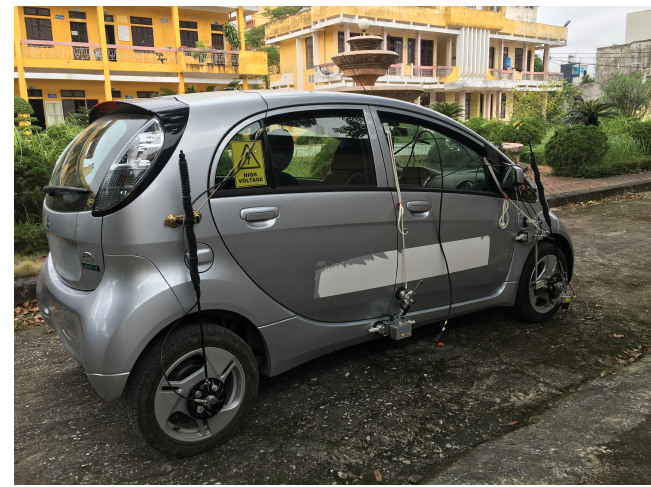
Figure 8. Experimental Mitsubishi i-MiEV.